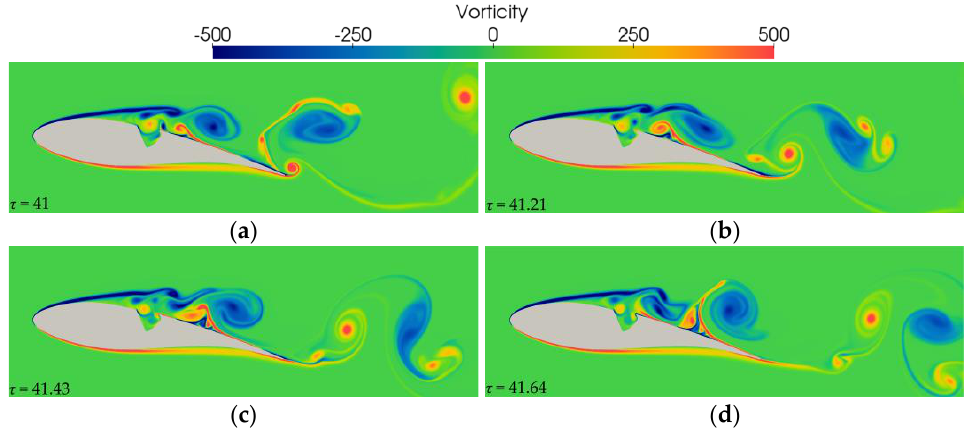
Figure 12. Evolution of vorticity for an airfoil with cavity A, α = 9°, sequence of images at ( a ) τ = 41, ( b ) τ = 41.21, ( c ) τ = 41.43, ( d ) τ = 41.64.